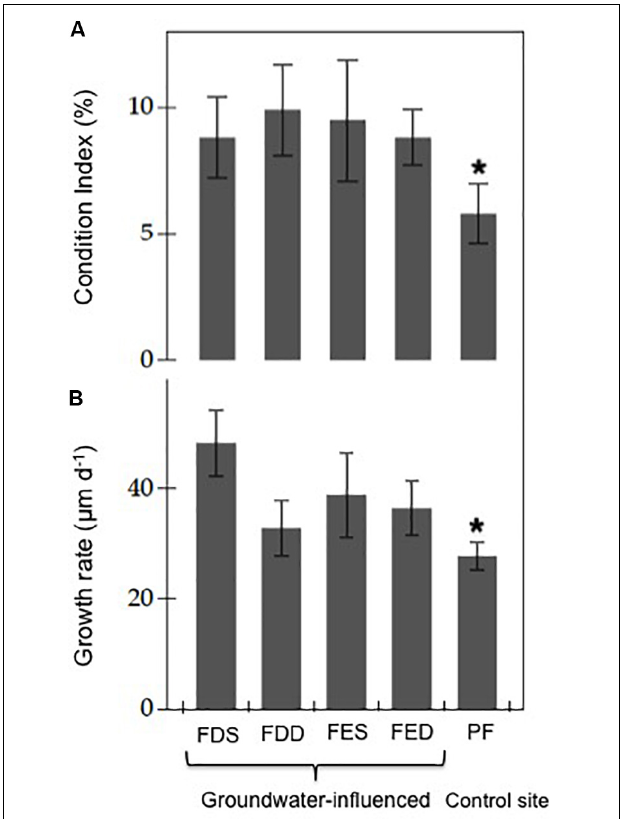
FIGURE 3 | (A) Mean ( ± SD) condition indices and (B) growth rate in groundwater-influenced sites (FDS: Font Dame Surface, FDD: Font